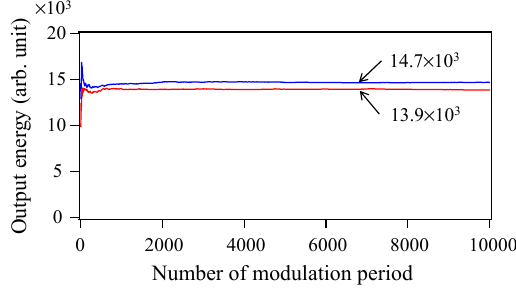
Figure 13. Temporal variations of the averaged THz-TDS outputs from 0 to 10,000 times the modulation period when Langevin noise is excluded (blue line) and included (red line).